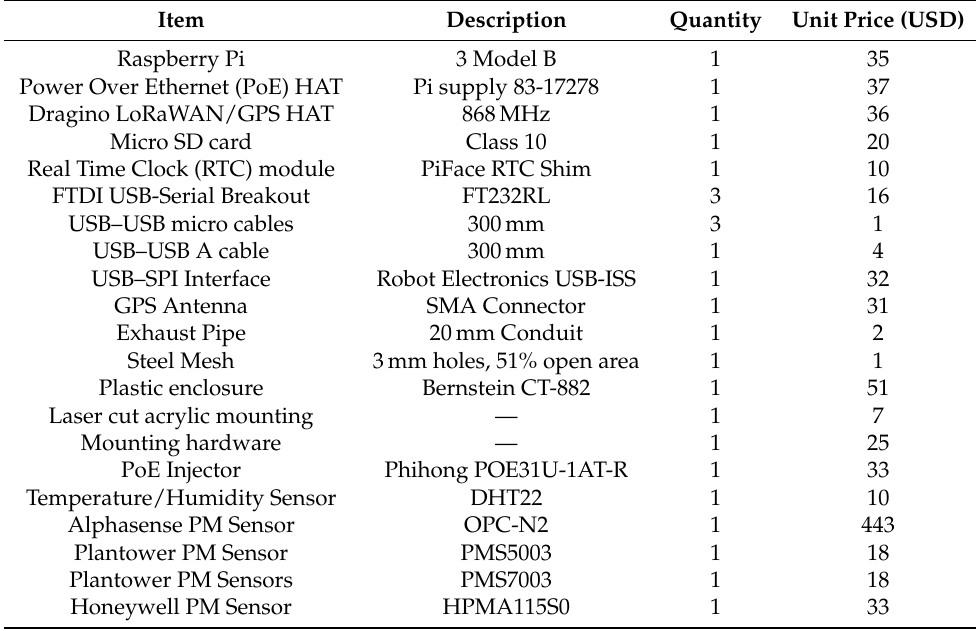
Table 3. List of hardware used to build the Air Quality (AQ) Internet of Things (IoT) device Version 1 at a total cost of ≈ 900USD; unit price correct as of November 2018. Each AQ IoT device contains four Particulate Matter (PM) sensors. The costs of laser cutting and labour have not been